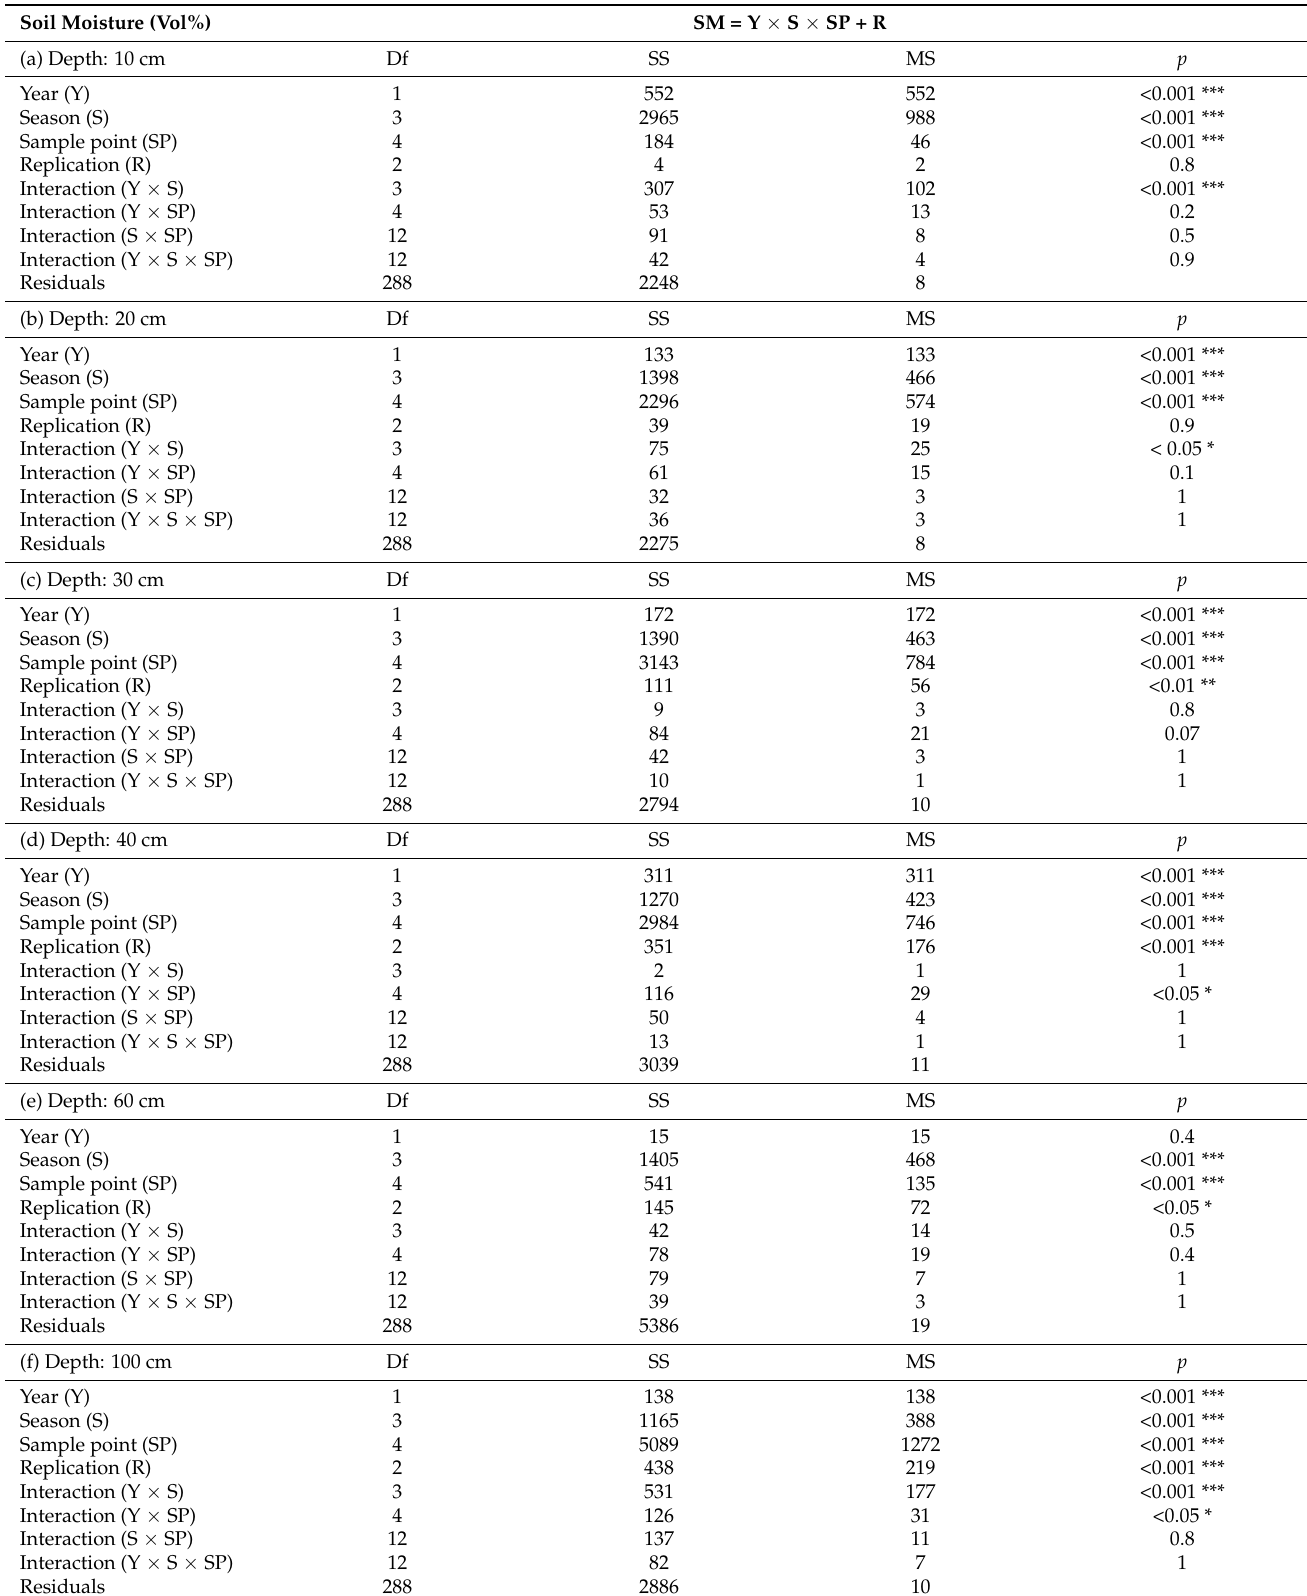
Table 2. Analysis of variance for soil moisture in depth (a) 10 cm (b) 20 cm (c) 30 cm (d) 40 cm (e) 60 cm and (f) 100 cm. ***, **, *: significant at p -value ≤ 0.001, ≤ 0.01, ≤ 0.05, respectively. Abbreviations: Df: degree of freedom; SS: sum of square; MS: mean